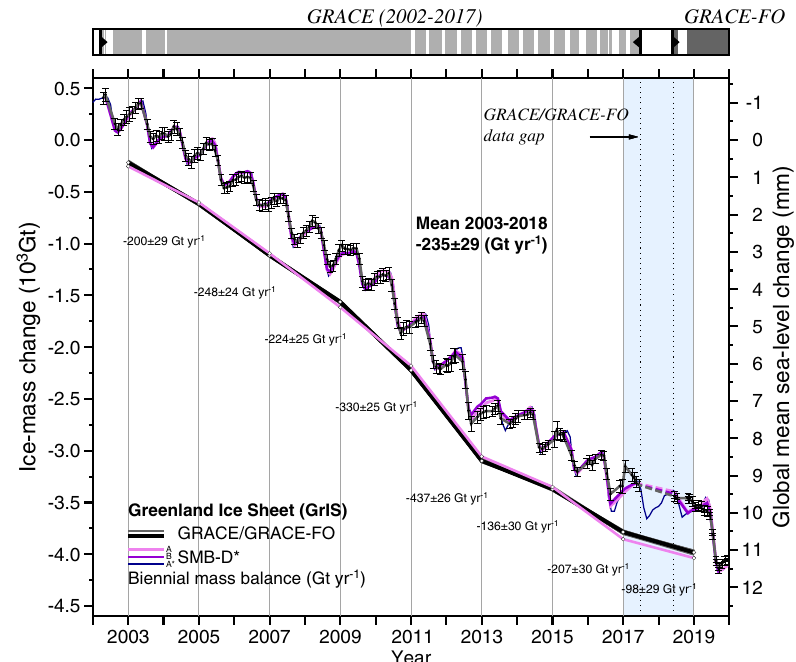
Fig. 1 Mass changes of the Greenland Ice Sheet between 2002 and 2019. Time series of mass change from the GRACE and GRACE-FO missions (black, with 2- σ error bars) and simulations using the regional climate models MARv3.10 30 (A; light violet) and RACMO2.3p2 31 (B; dark violet) and calibrated out fl ow measurements from feature tracking of optical and radar imagery (SMB-D*), updated from 32 ( “ Methods ” section). The top bar indicates the availability of GRACE and GRACE-FO measurements, the vertical dashed lines frame the data gap between both missions. The blue shading covers the biennial period 2017 – 2018, which contains the GRACE/GRACE-FO data gap (dotted line). The monthly SMB-D* data shown for MARv3.10 (A*; dark blue) are linearly interpolated to match the GRACE/GRACE-FO measurement timeframes. Both datasets are fi tted with a biennial piecewise linear trend (breakpoints on January 1st of each year), revealing accelerated mass losses until 2012, followed by a slowdown and particularly small loss during the years 2017 and 2018. Values denote biennial mass balances in Gt year − 1